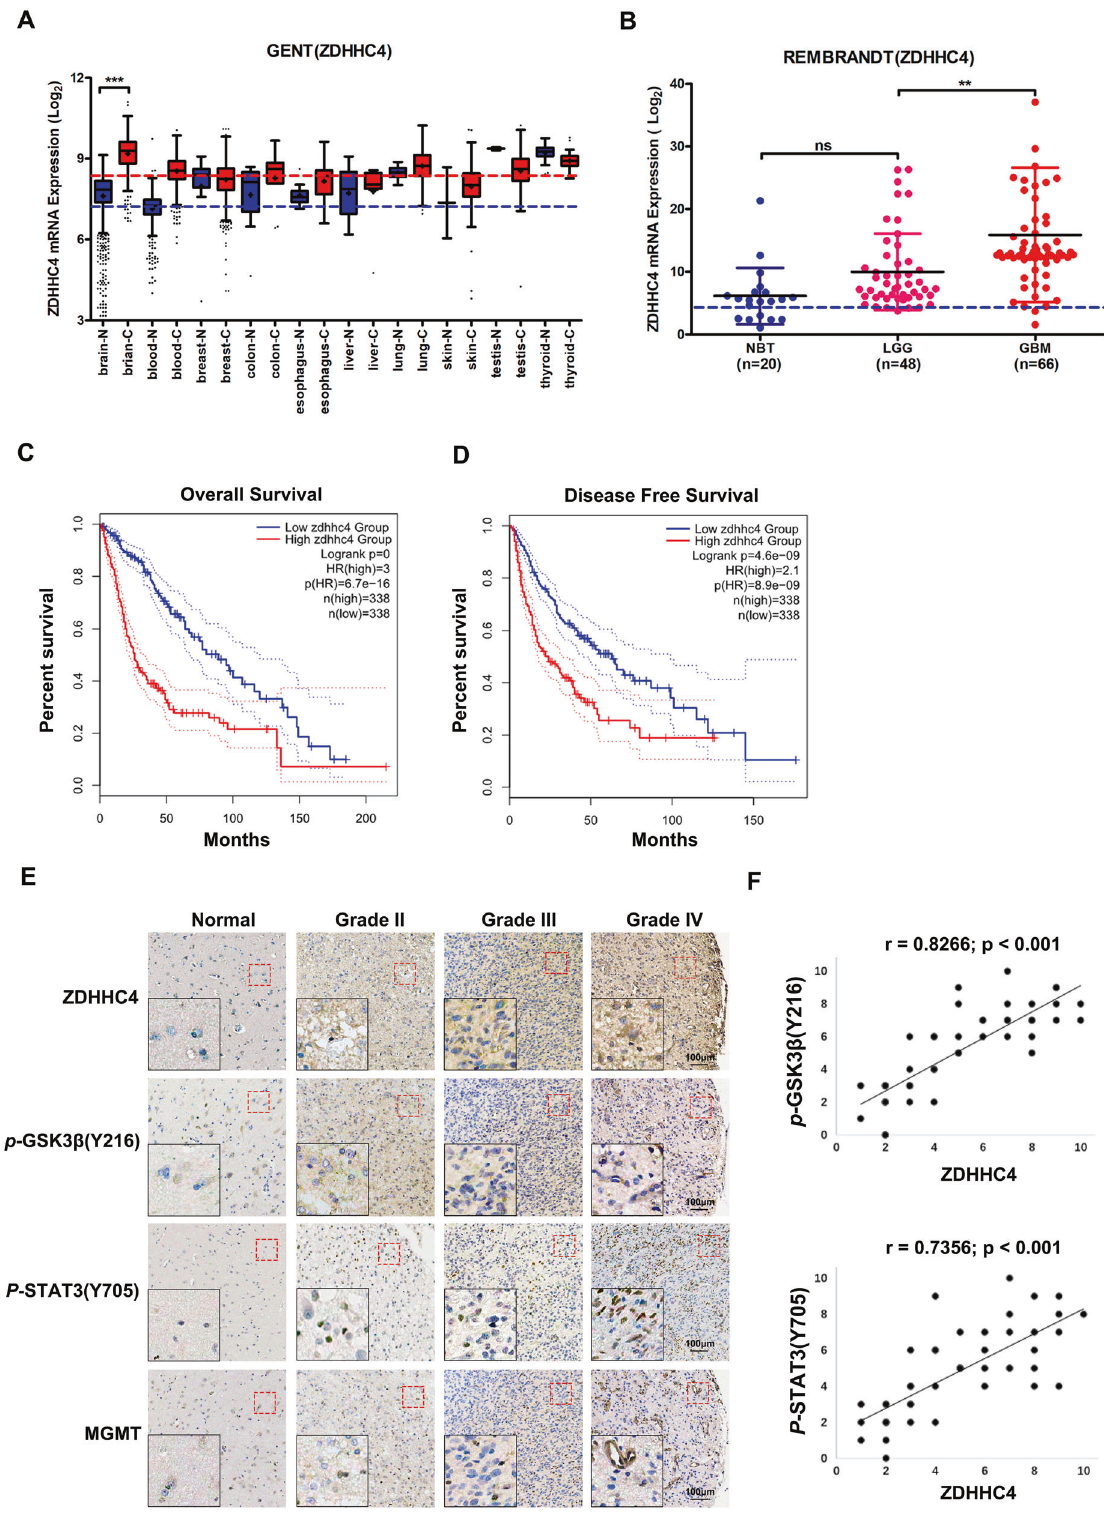
Fig. 6 The ZDHHC4 – GSK3 β – STAT3 axis was correlated with the malignant degree of human glioma. A Differences in ZDHHC4 expression in tumors and normal tissues of various organs obtained from the GENT database. B Relationship of ZDHHC4 to glioma grade from the REMBRANDT database. C , D Diagram of ZDHHC4 expression with overall survival and disease-free survival in glioma patients obtained from TCGA database. E Immunohistochemical staining showed that ZDHHC4 expression was correlated with p- GSK3 β (Y216), p- STAT3 (Y705), and MGMT; 125 biologically independent samples were analyzed. The red dotted line marks the area corresponding to the high magni fi cation image. F Statistical analysis of the Pearson correlation between the immunohistochemical staining score of ZDHHC4 expression and p- GSK3 β (Y216) or p- STAT3 (Y705)